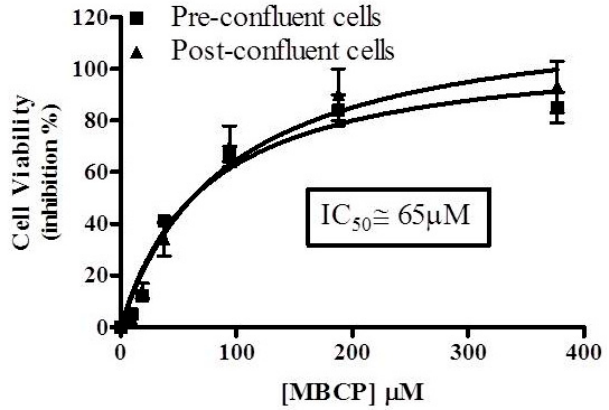
Figure 1. MBCP reduces cell viability in Caco-2 cells. Cell viability was evaluated by the Neutral Red assay in pre and post-confluent Caco-2 cells. Cells were incubated with increasing concentration of MBCP (9–375 µ M) for 48 h. Each point represents the mean ± SD of three independent experiments.